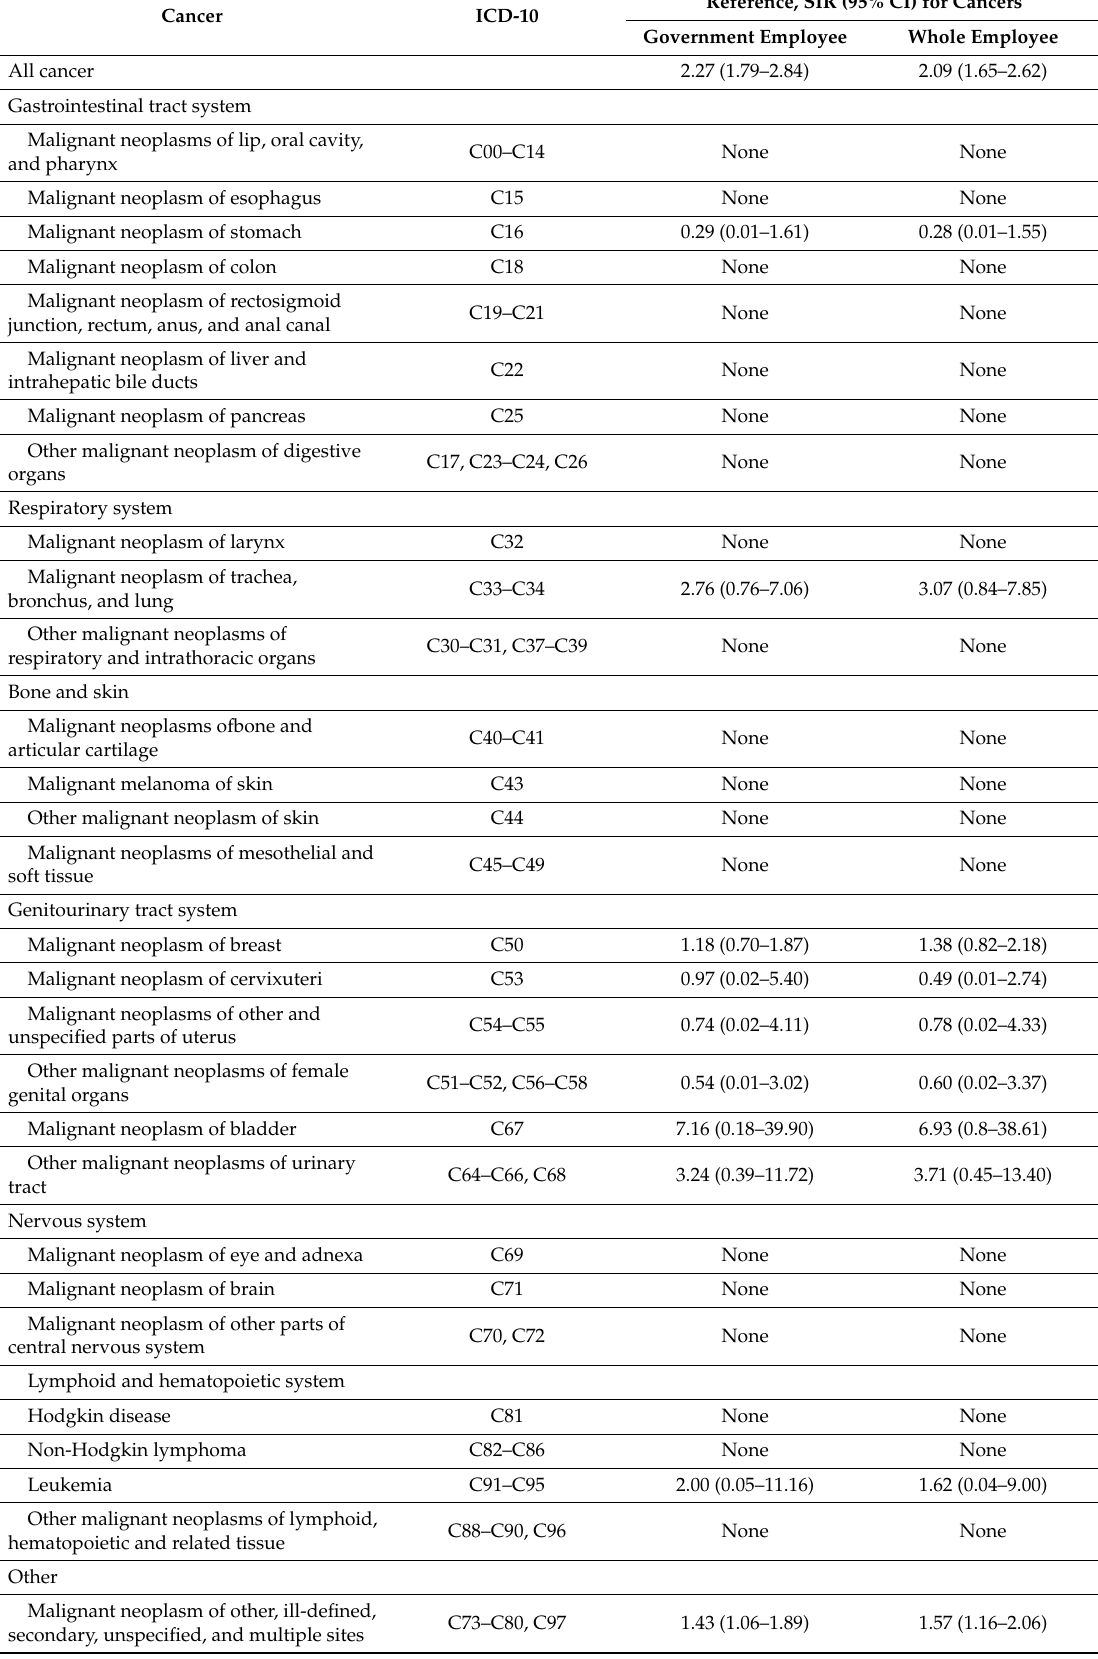
Table 3. The age-standardized Incidence Ratios (SIR) and 95% confidence interval (CI) of the air transportation industry female workers for cancers according to reference